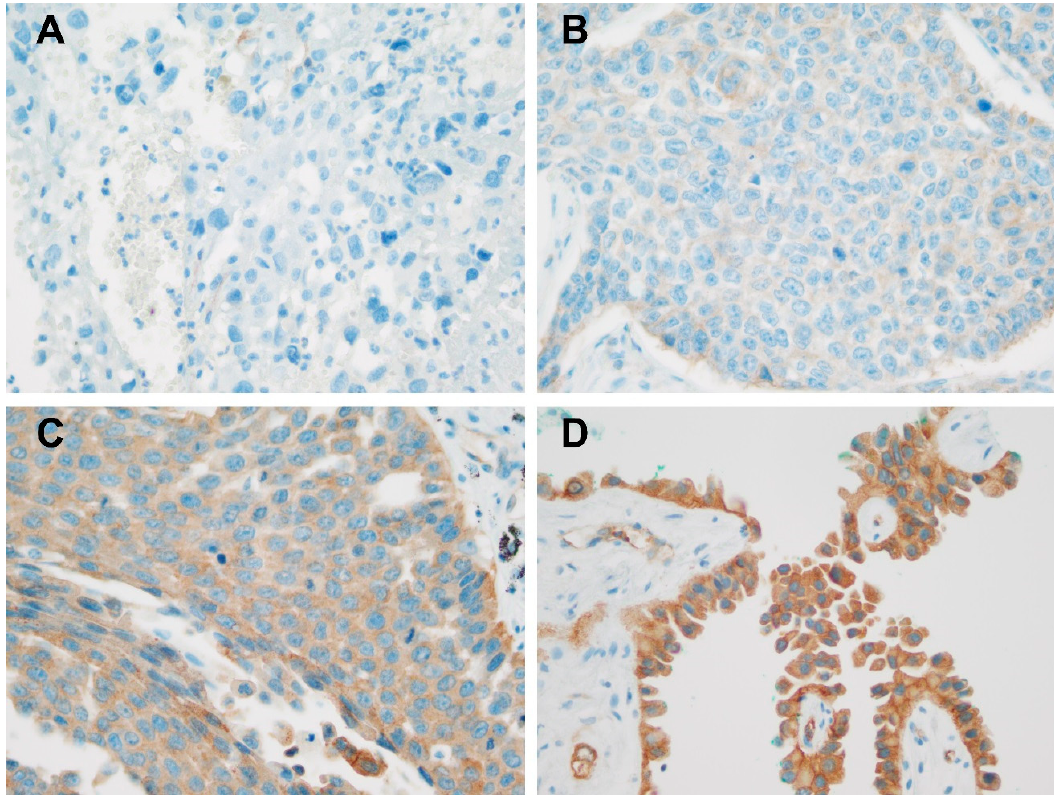
Figure 1. Huntingtin-interacting protein 1-related protein (HIP1R) expression in nonsmall cell carcinoma. ( A ) No staining of HIP1R, x400. ( B ) Faint HIP1R staining, X400. ( C ) Moderate HIP1R staining, X400. ( D ) Strong HIP1R staining, X400.